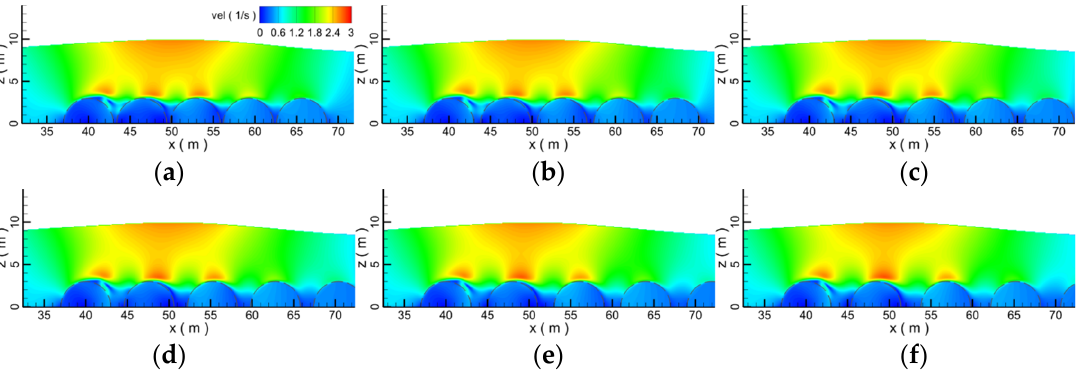
Figure 15. The velocity contour of the wave peak on the breakwaters under different distances; ( a ) s = 0.4 m; ( b ) s = 0.8 m; ( c ) s = 1.2 m; ( d ) s = 1.6 m; ( e ) s = 2.0 m; ( f ) s = 2.4 m.